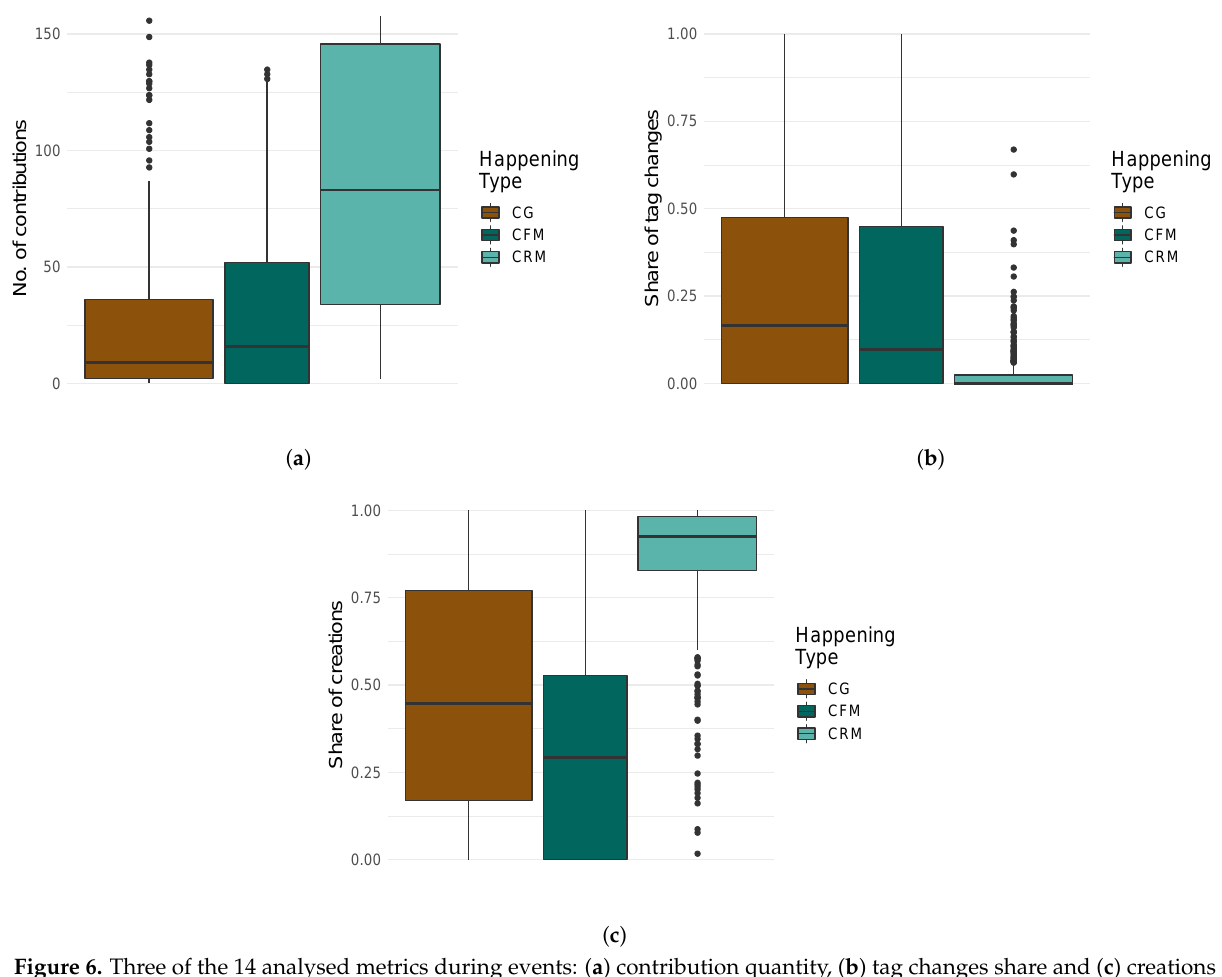
Figure 6. Three of the 14 analysed metrics during events: ( a ) contribution quantity, ( b ) tag changes share and ( c ) creations share. The median quantity of edits and the share of creations were significantly higher for CRM mappers while having a lower tag change rate. CFMs created less data. The width of the boxes is relative to the number of mappers in the respective class (see Table 3). Graph ( a ) was cropped at 150 contributions, but the total maximum was